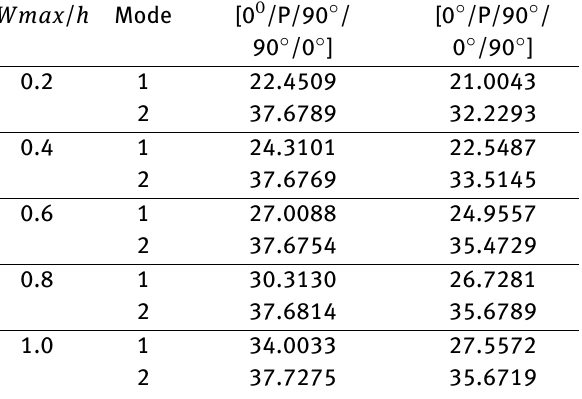
Table 5: Effect of amplitude ratio, frequency mode and stacking sequence on dimensionless mean nonlinear natural frequency of the conical shell panel.